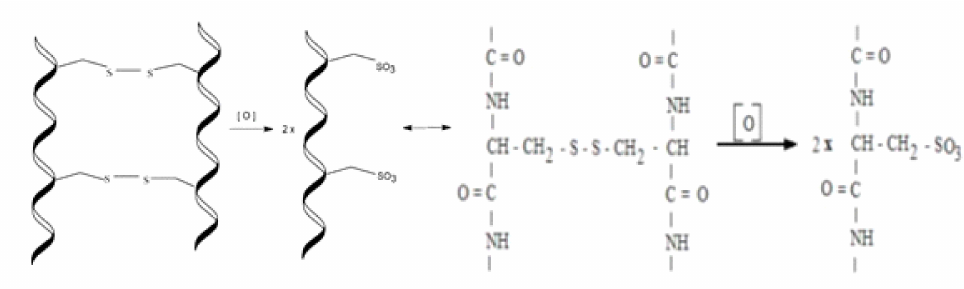
Figure 3. Splitting reaction of disulfide bond from keratin oxidation to sulfonic groups.